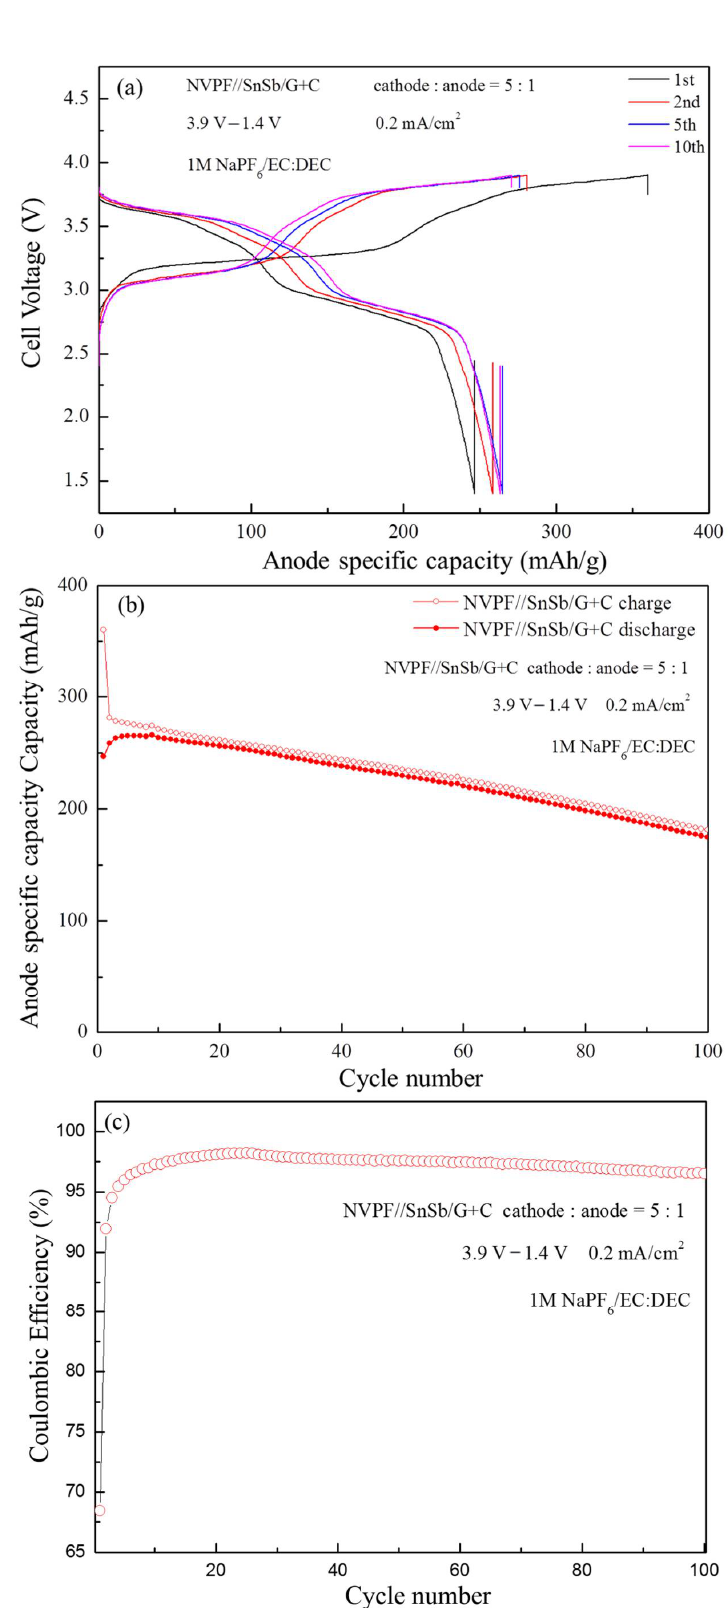
Figure 5. ( a ) Voltage profile and ( b ) Cyclability of the NVPF//SnSb/RGO+HC cells ( c ) Coulombic efficiencies of NVPF//SnSb/RGO+HC cells.